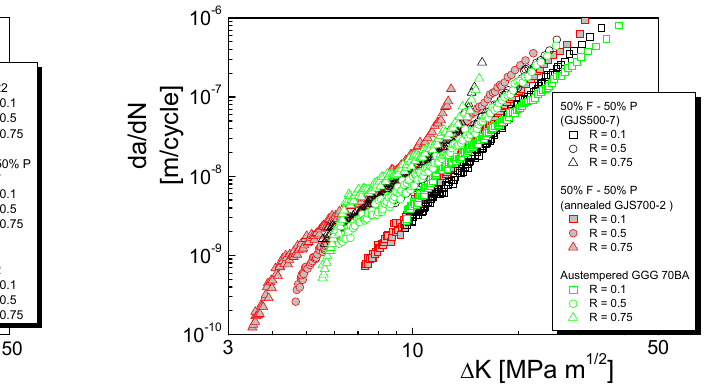
Figure 14: DCI fatigue crack propagation resistance in ferritic- pearlitic and austempered DCIs.